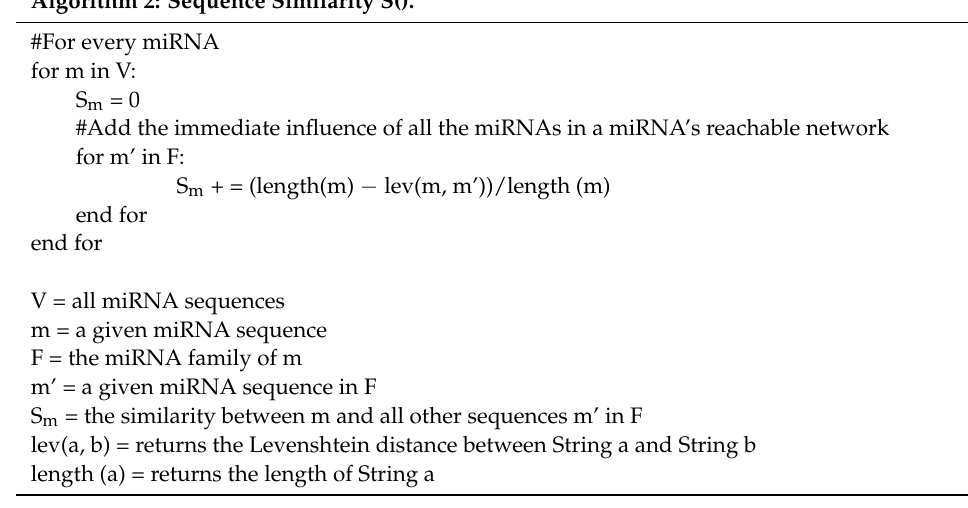
Algorithm 2: Sequence Similarity